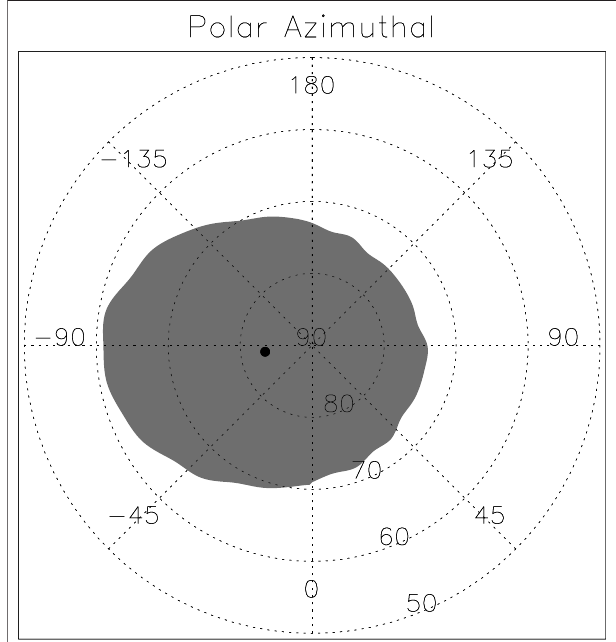
FIGURE 10 | Schematic diagram of EPWs de fi ned in the article. Here, we use 200 MV as the cutoff rigidity, and the black dot represents the center of the EPW.